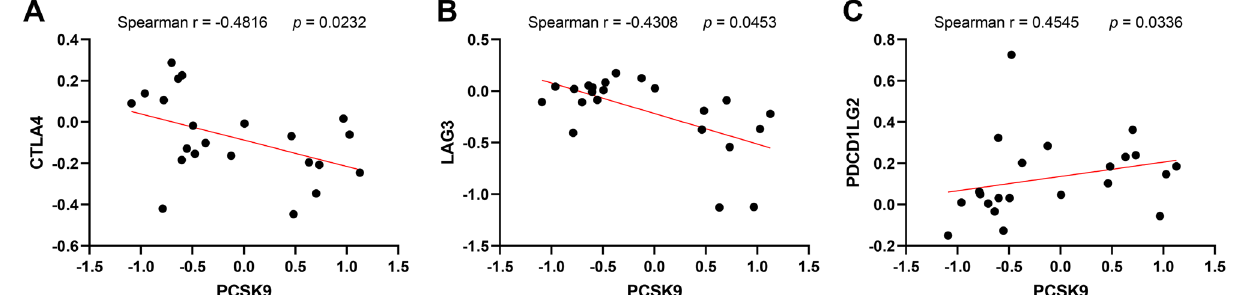
Figure 5. The correlation between PCSK9 and immune checkpoints in AAA neck and donor tissues. ( A ) Spearman’s correlation analysis of the expression data from GSE47472 showed that PCSK9 was negatively related to CTLA4. Spearman’s Rank Correlation Coefficient (Spearman r = − 0.4816, p = 0.0232). ( B ) Spearman’s correlation analysis of the expression data from GSE47472 showed PCSK9 was negatively related to LAG3 (Spearman r = − 0.4308, p = 0.0453). ( C ) Spearman’s correlation analysis of the expression data from GSE47472 showed PCSK9 was positively related to PDCD1LG2 (Spearman r = − 0.4308, p =